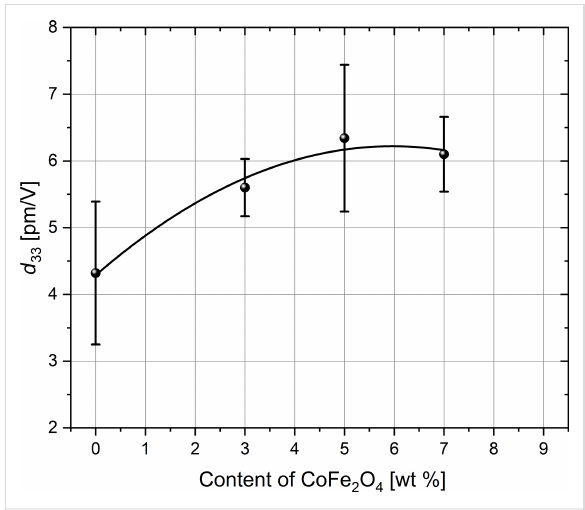
Figure 2: Value of d 33 of the nanocomposites as a function of the CoFe 2 O 4 content.